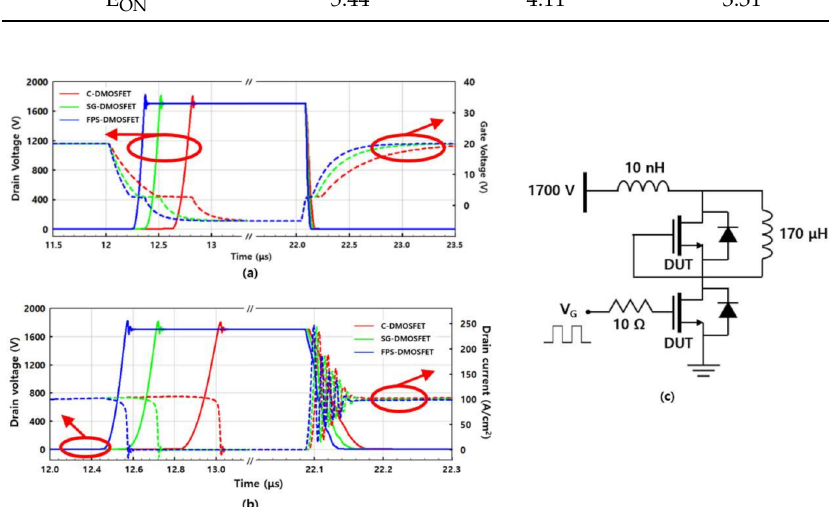
Figure 14. The switching waveforms of three structures extracted by double pulse test simulation. ( a ) drain voltage and gate voltage waveforms; ( b ) drain voltage and drain current waveforms; and ( c ) the test circuit for double pulse test